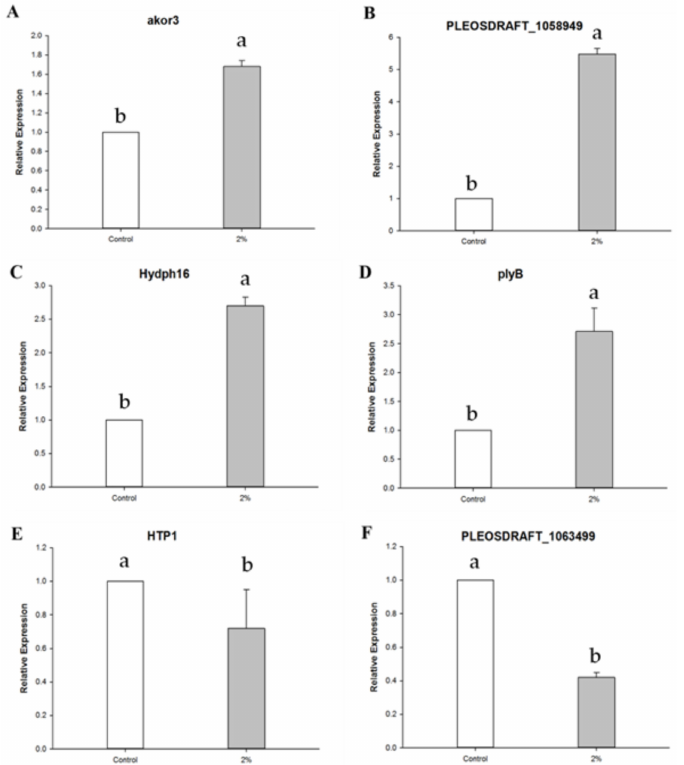
Figure 4. qRT-PCR results normalized using delta-delta ct method. Means with different letters within a row are significantly different from each other at p <0.05 as determined by Duncan’s multiple range